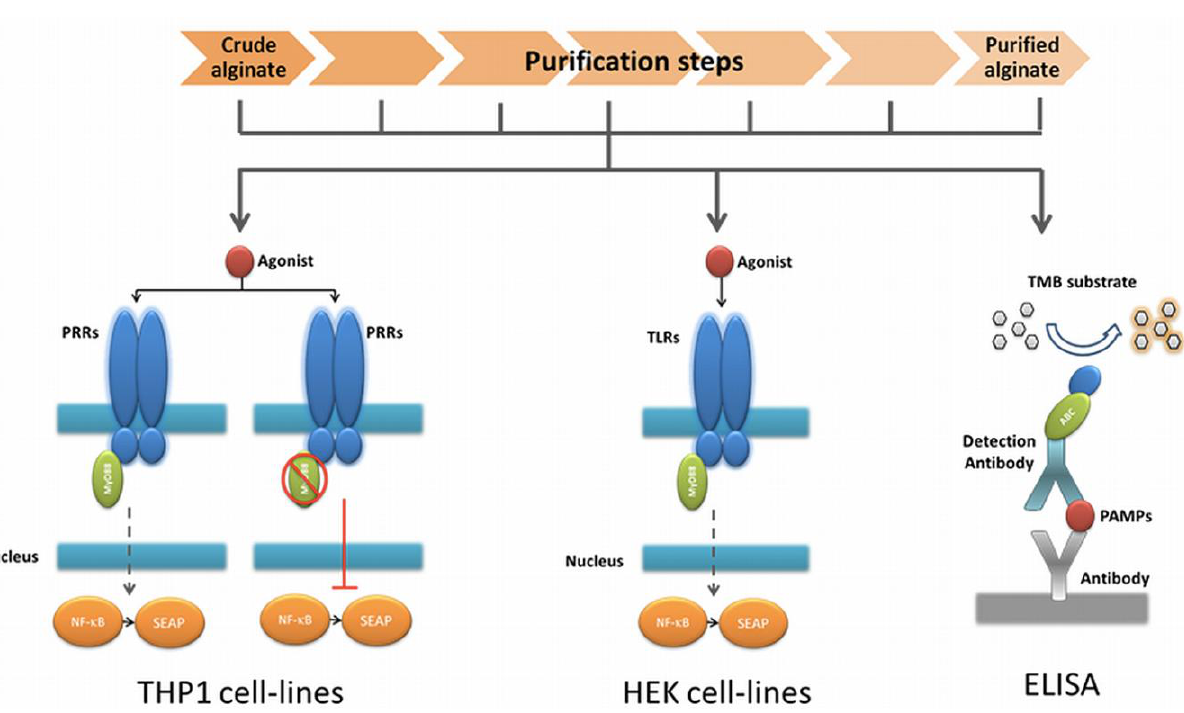
Figure 1. Technology to assess the immunostimulatory capacity of alginate, to determine where in the purification process the pathogen associated molecular patterns (PAMPs) are removed, and which Toll-like receptors (TLRs) and ligands are being involved. We applied a THP1 monocytic cell-line in the first step to determine the immunostimulatory capacity of the alginate. Next, we applied a THP1 with a non-functional MyD88 coupling protein. This allowed us to confirm that the immune stimulation is PRR dependent. In the next step, HEK cell-lines that possess the specific receptors were applied. This approach allows for scaling down the number of candidate PAMPs that might be responsible for the response. The last step was application of an enzyme-linked immunosorbent assays to identify the specific